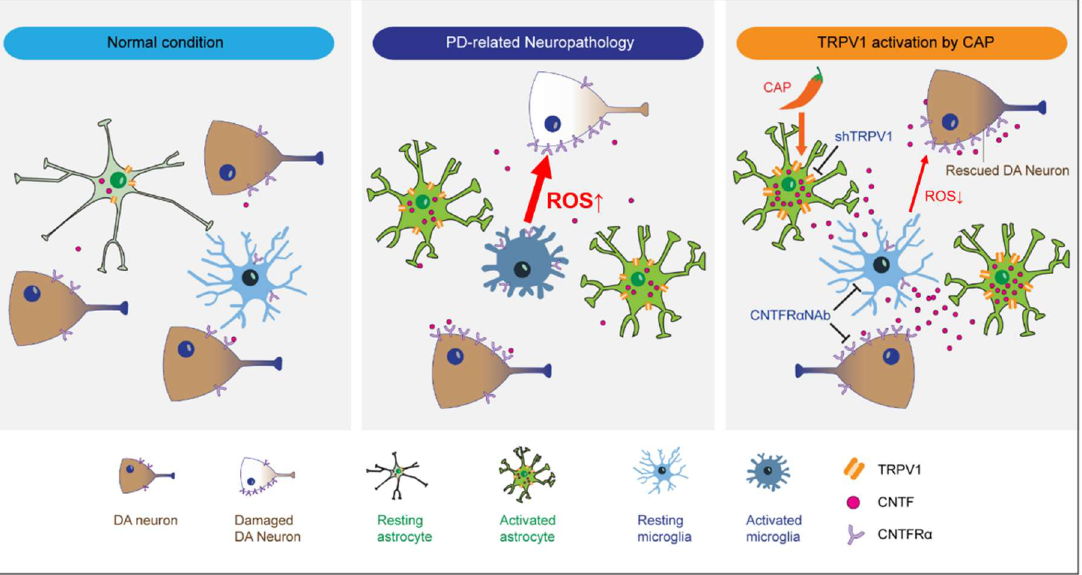
Figure 7. Microglial ROS production is attenuated by astrocytic TRPV1-derived CNTF, resulting in survival of nigral dopamine neurons in Parkinson’s disease. There is a dramatic expression of CNTFR α in reactive microglia in the substantia nigra pars compacta (SNpc) of human Parkinson’s disease and Parkinson’s disease-related neuropathology, compared to the respective controls. Note that astrocytic TRPV1-derived CNTF by CAP inhibits microglial ROS production through CNTFR α on microglia and rescues dopamine neurons in the SNpc of Parkinson’s disease in vivo. TRPV1, Transient Receptor Potential Vanilloid 1; shTRPV1, TRPV1 shRNA lentivirus; DA, Dopamine; CNTF, Ciliary Neurotrophic Factor; CNTFR α , CNTF receptor alpha; CNTFR α NAb, CNTF receptor alpha neutralizing antibody; CAP, capsaicin.